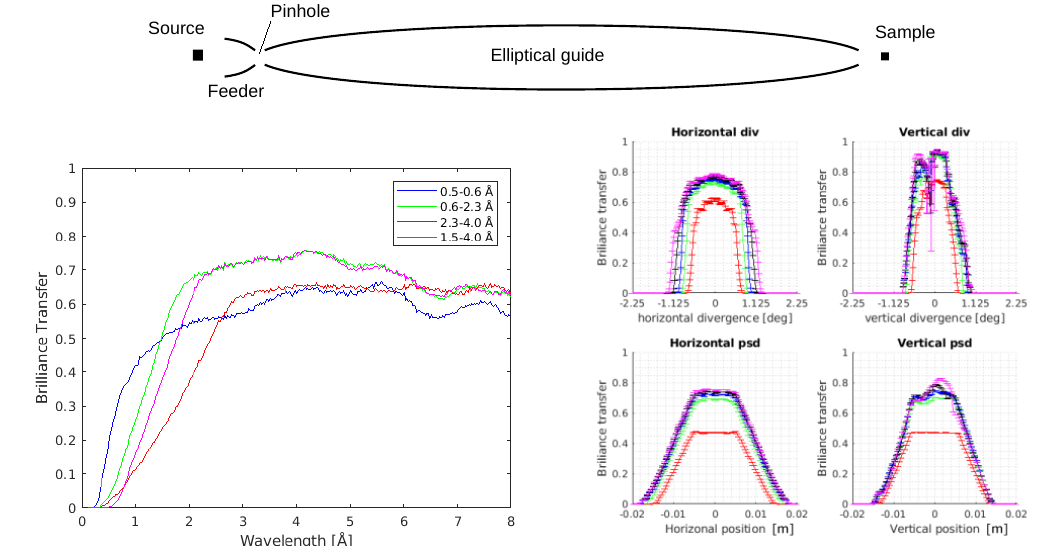
Figure 2. Benchmark 1. Performance of coating-optimized benchmark 1 guides. Top: Schematic drawing of the guide systems that is not to scale. Left: Simulated values of BT ( λ ) as a function of neutron wavelength optimized for coating value and geometry for the wavelength bands WB1 (blue), WB2 (green), WB3b (purple), and WB3a (red), using a pinhole with the size: height × width = 5 × 3 cm 2 . Right: Integrated BT of the single-pinhole guide, optimized for WB3b, 1.5–4.0 Å. The panels show the BT as a function of horizontal/vertical position and divergence for different wavelengths marked by colors (red: 1.5 Å, green: 2.1 Å, blue: 2.8 Å, black: 3.4 Å, purple: 4.0 Å).